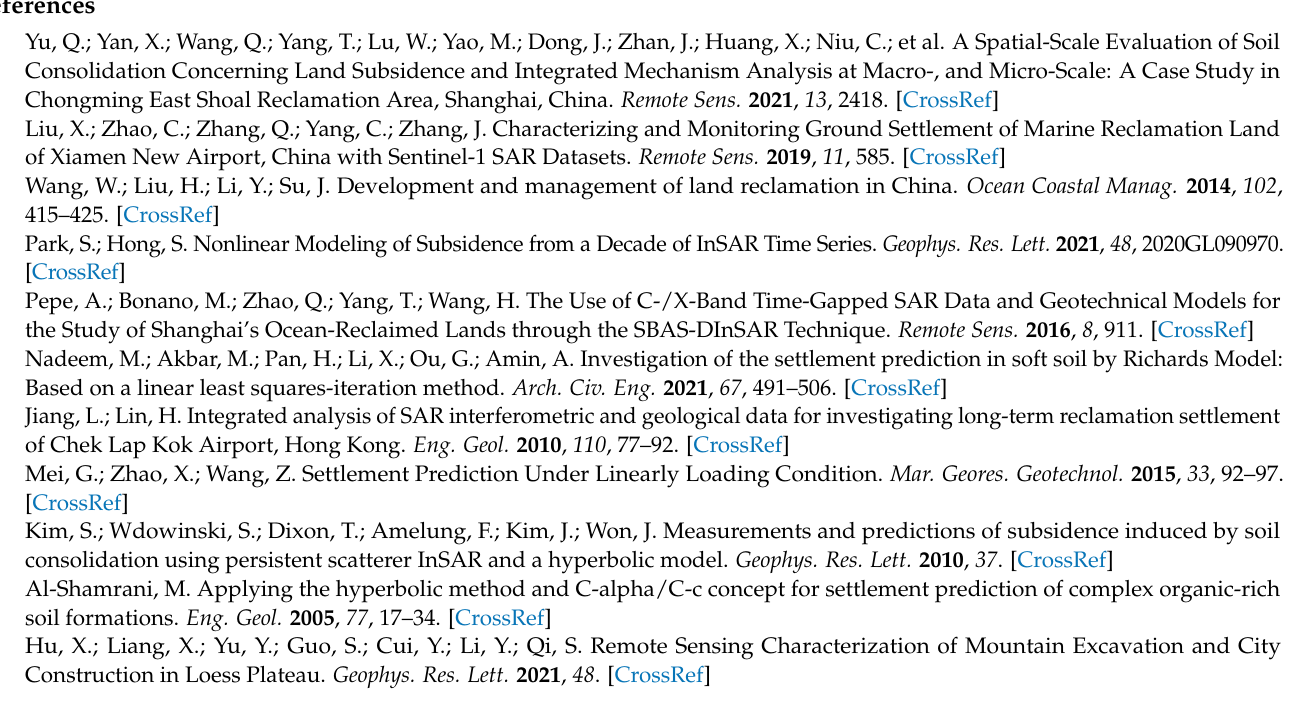
Figure A3. Optical images of the white dotted rectangle area in Figure 12. Optical image acquired on ( a ) 16 June 2015, ( b ) 24 June 2016, ( c ) 10 July 2017, ( d ) 2 June 2018, ( e ) 26 July 2019, and ( f ) 7 December 2019.